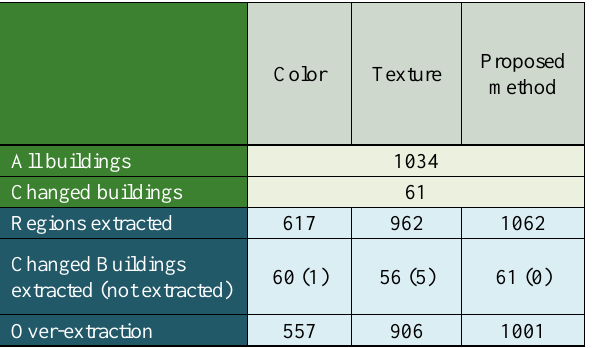
Table 5. Extraction results of changed buildings in Site1